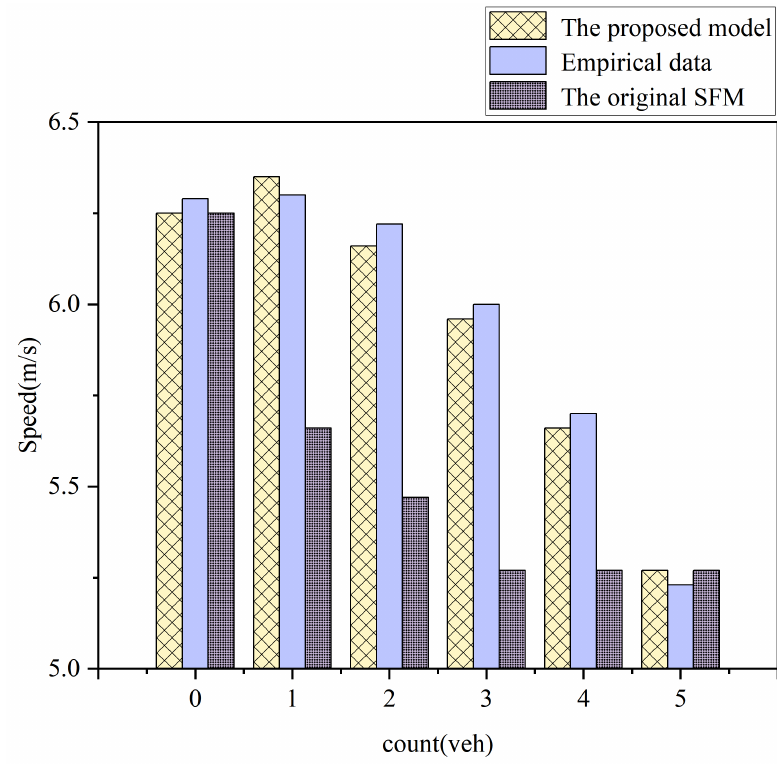
Figure 11. The effect of bicycle ratio on the average speed of the